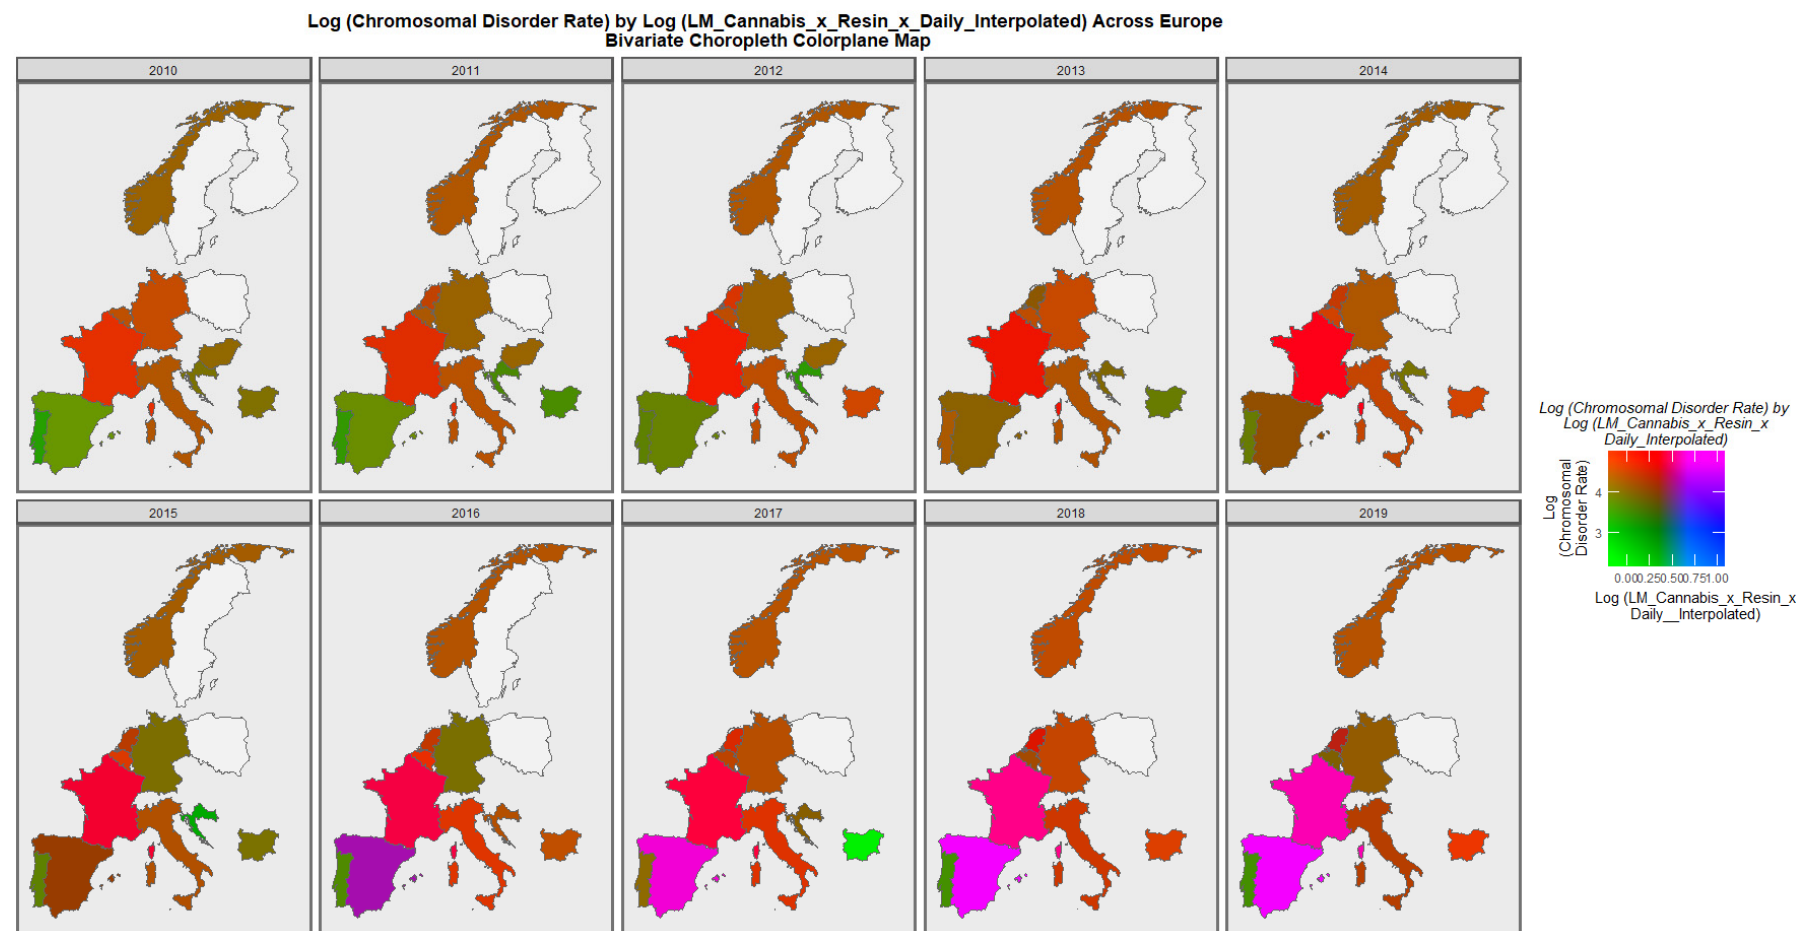
Figure 6. Bivariate choropleth sequential map-graph of log (chromosomal disorder rates) by last month cannabis use: cannabis resin THC concentration: daily cannabis use interpolated over time in selected European nations 2010–2019.